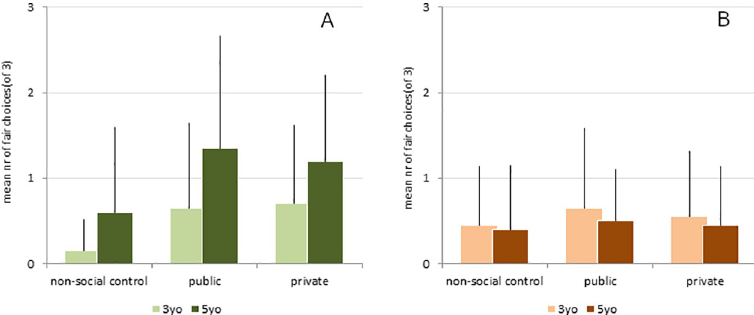
Fig 3. Results. Mean number and standard deviation of fair choices out of three trials (a) in the procedure choice test and (b) the distribution choice test.